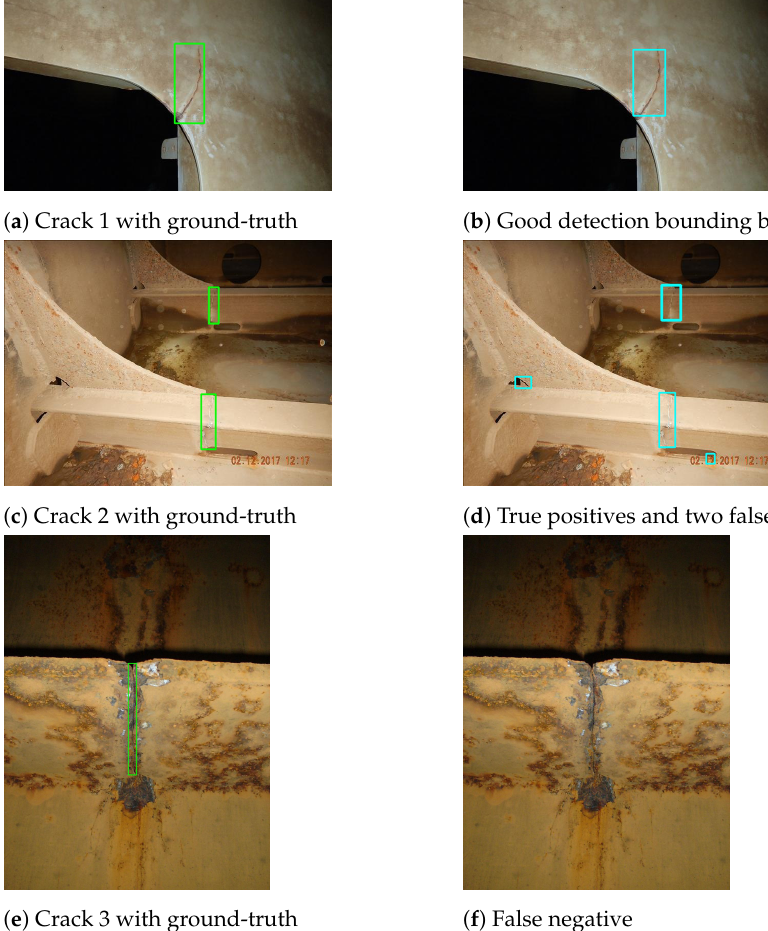
Figure 6. Examples of object detection test